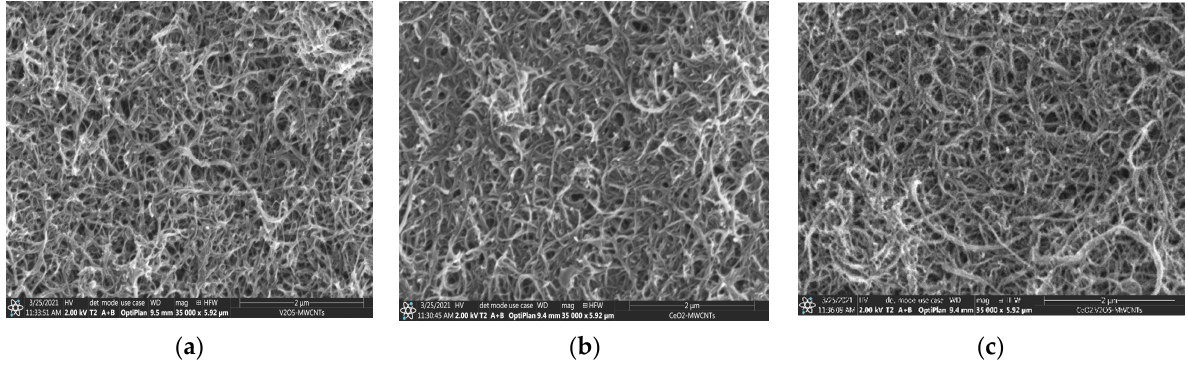
Figure 3. SEM images on scale of 2 µm: ( a ) V/MWCNTs, ( b ) Ce/MWCNTs, ( c ) V:Ce/MWCNTs.